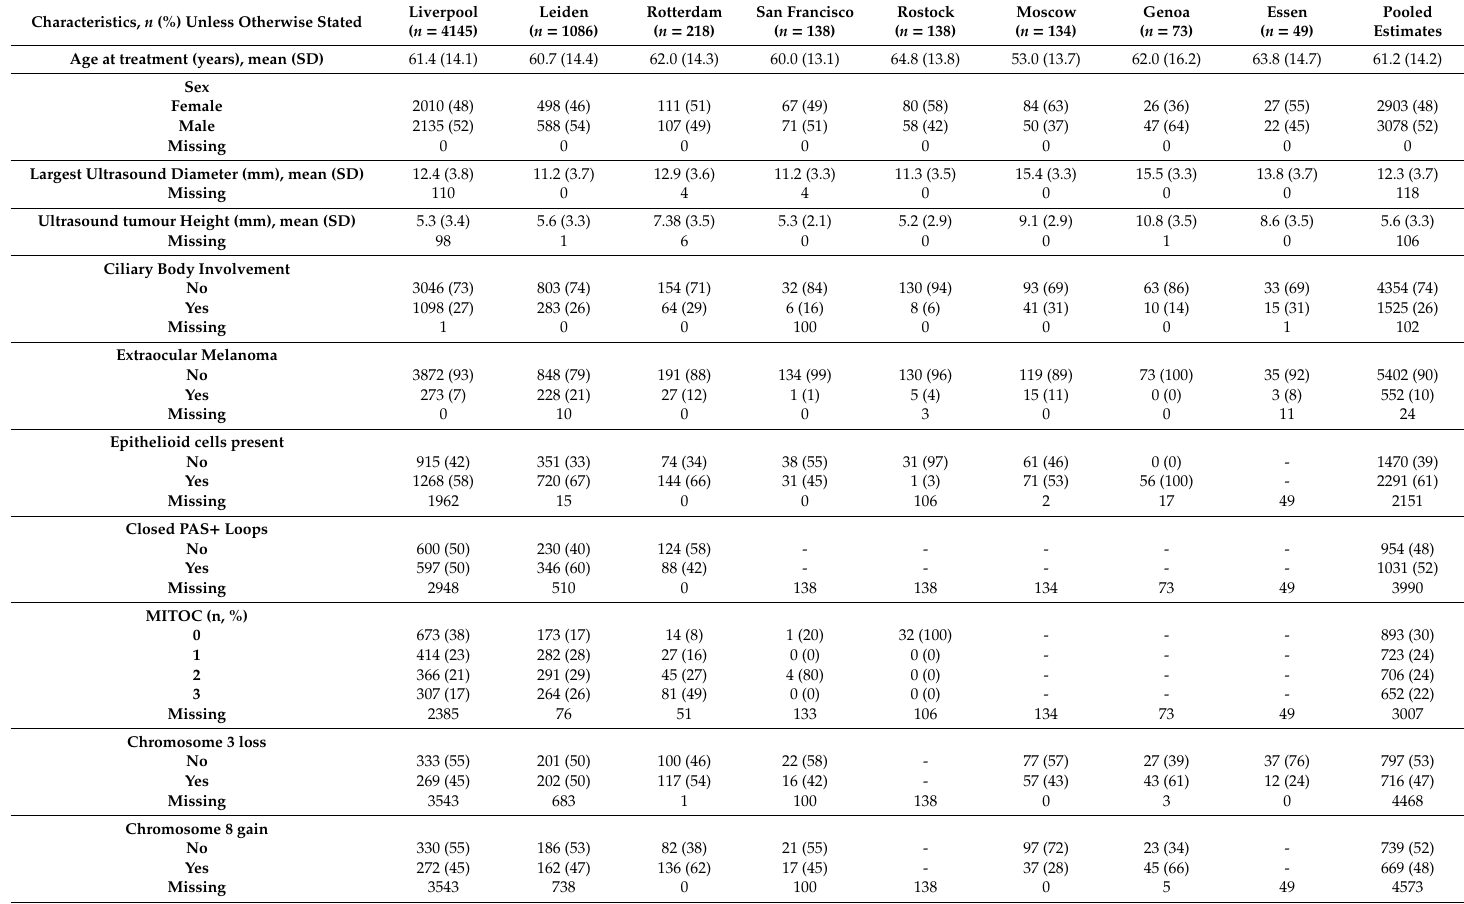
Table 1. Patient characteristics. Development data (Liverpool) and external validation data (from seven ocular oncology centers—Leiden, Rotterdam, San Francisco, Rostock, Moscow, Genoa and Essen). The last column reports the pooled estimates of the characteristics. Characteristics, n (%) Unless Otherwise